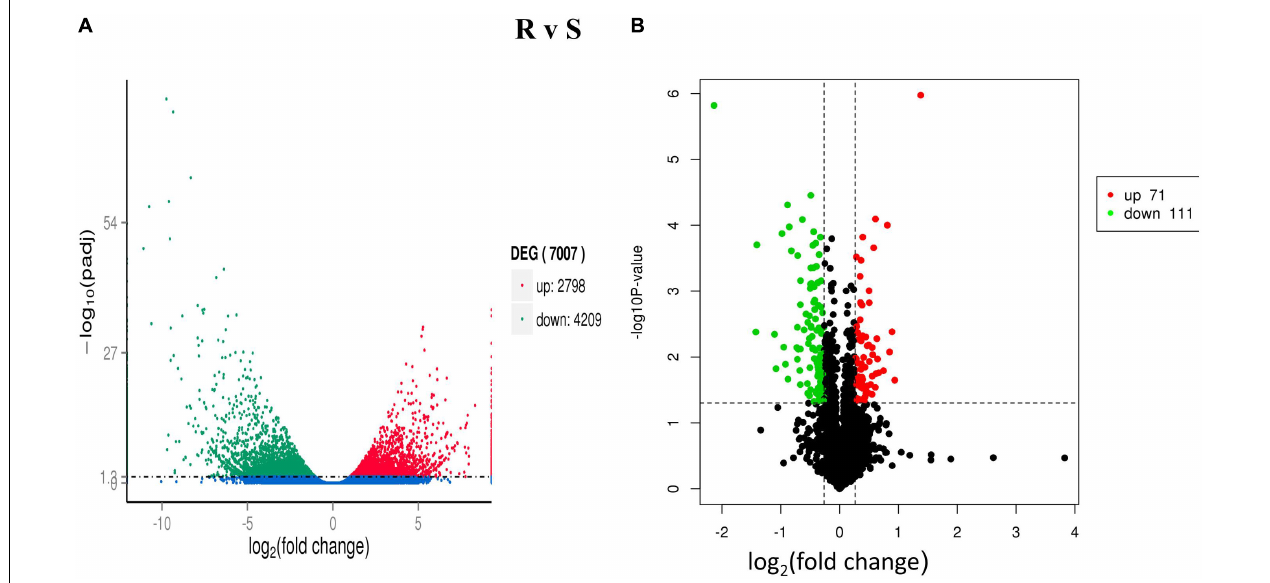
FIGURE 1 | Differentially expressed genes (DEGs) and proteins (DEPs) between Cry1Ah-resistant and susceptible Ostrinia furnacalis . (A) The distribution of DEGs. The scatter in the figure represents each gene, green genes are down-regulated, red genes are up-regulated, and blue genes are not differentially expressed. (B) The distribution of differentially expressed proteins (DEPs). The vertical axis indicates the P -value (–log 10 value), black indicates the protein with no significant difference, red indicates the up-regulated proteins ( ≥ 1.2-fold, P ≤ 0.05), and green indicates the down-regulated proteins ( ≤ 0.8-fold, P ≤